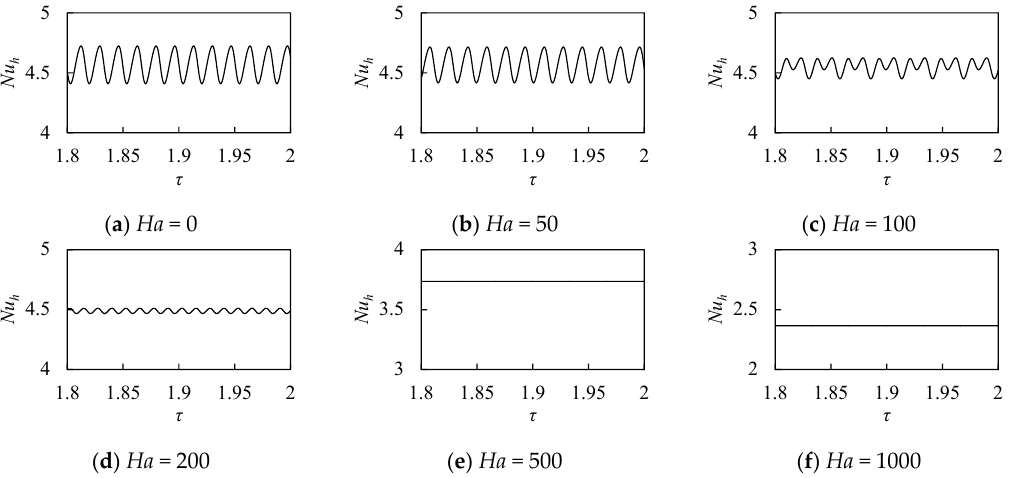
Figure 9. Time development of Nu h at κ = 0.5 and Ra = 5 × 10 5 .